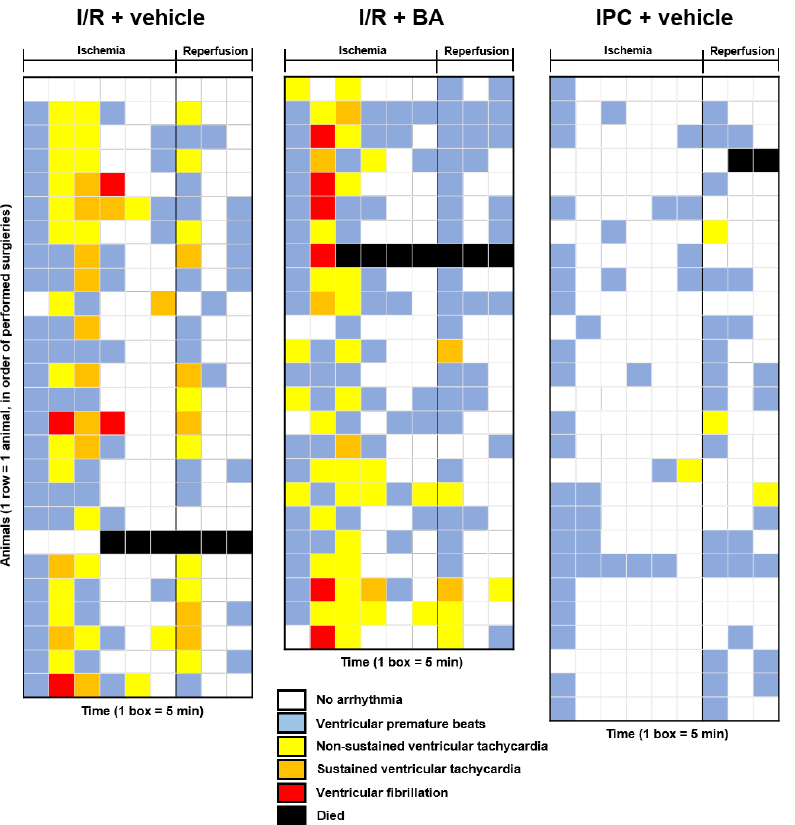
Figure 4. Arrhythmia maps. The most severe arrhythmia is shown in 5 min intervals during the 30 min of ischemia and at the first 15 min of reperfusion, in the order of performed surgeries. Each row represents arrhythmias of one animal. Each box shows 5 min periods colored according to the most severe arrhythmia. Animals that died during IPC ( n = 1) are not shown on the arrhythmia map. BA: bempedoic acid. I/R: ischemia/reperfusion. IPC: ischemic preconditioning.